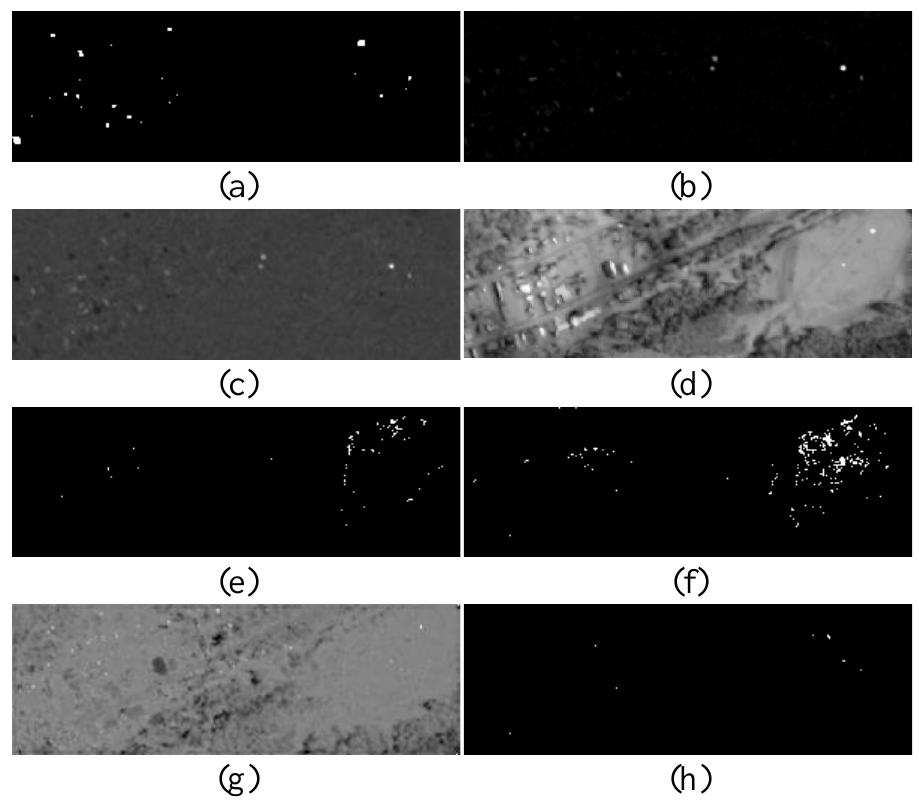
Figure 12. Detection maps for the Gulfport dataset when p f is fixed to 0.1: ( a ) Constrained energy minimization (CEM) p d = 0.84. ( b ) adaptive cosine estimation (ACE) p d = 0.81. ( c ) matched filter (MF) p d = 0.90. ( d ) Sparse and Low-Rank Matrix Decomposition (SLMD) p d = 0.98. ( e ) one-class support vector machine (OC-SVM) p d = 0.95. ( f ) sparse representation detector (SRD) p d = 0.94. ( g ) combining sparse and collaborative representations (CSCR) p d = 0.99. ( h ) l p -norm-based sparse representation detector (Lp-SRD) p d = 1.00.